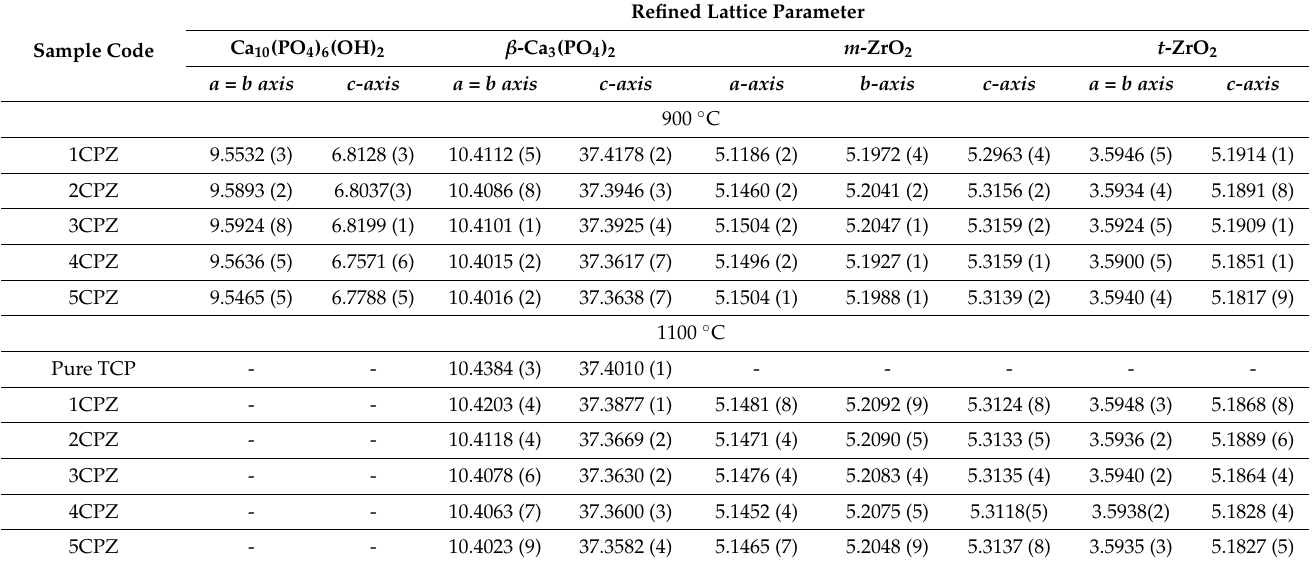
Table 3. Refined lattice parameters for the different phases for the pure TCP and five composites at 900 and 1100 ◦